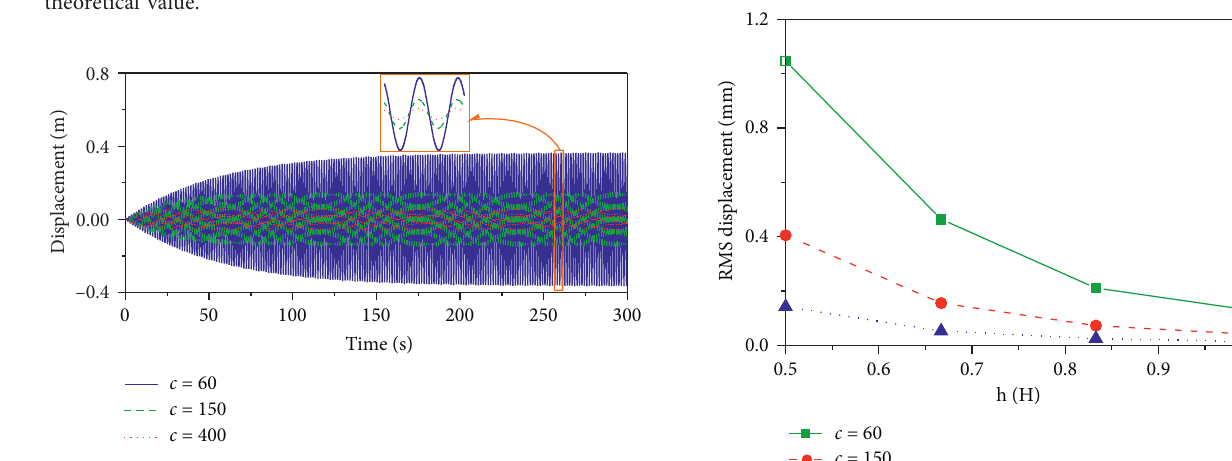
Figure 5: Structural response displacement time history under vortex excitation.